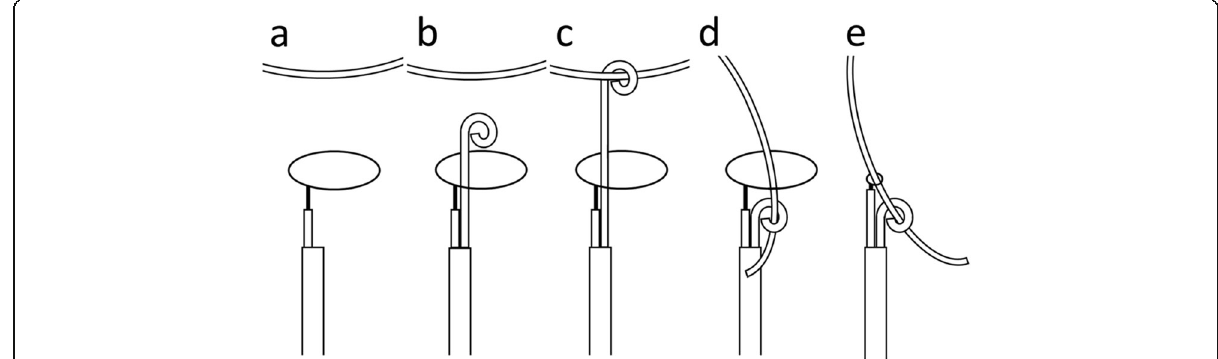
Fig. 3 Schematic drawing of the “ pigtail through snare ” technique. a A snare loop initially opens near the target catheter fragment with inaccessible ends. b A pigtail catheter passes through the snare loop in advance. c The pigtail catheter hooks the catheter fragment. d The pigtail catheter pulls the catheter fragment that falls automatically into the snare loop. e The snare loop grasps the catheter fragment at the initial